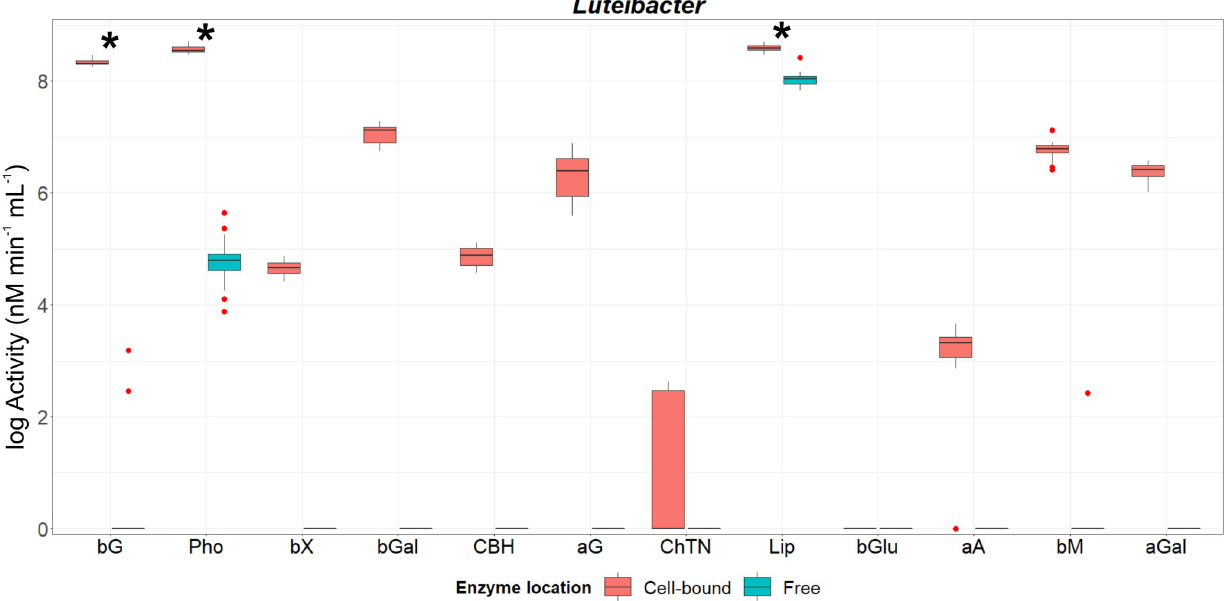
Fig 1. Activity of cell-associated and freely-released enzymes from genus Luteibacter . Box and whiskers were represented in the style of Tukey. Hinges correspond to the 1 st and 3 th quartiles and medians of the activity of each enzyme recorded for all strains are represented by horizontal lines. Red points correspond to those data beyond 1.5 x Inter Quartile Range. An ‘ � ’ indicates significant differences between the activity of those enzymes detected in both fractions calculated with the non-parametric Mann-Whitney U test at a confidence level of 95%. Abbreviations of enzymes: bG: β -glucosidase; Pho: acid phosphatase; bX : β -xylosidase; bGal : β -galactosidase; CBH: cellobiohydrolase; aG : α -glucosidase; ChTN: chitinase; Lip: lipase; bGlu : β -glucuronidase; aA : α -arabinosidase; bM : β -mannosidase; aGal : α -galactosidase. All the data were log-transformed for graphical clarity by fitting the same scale.